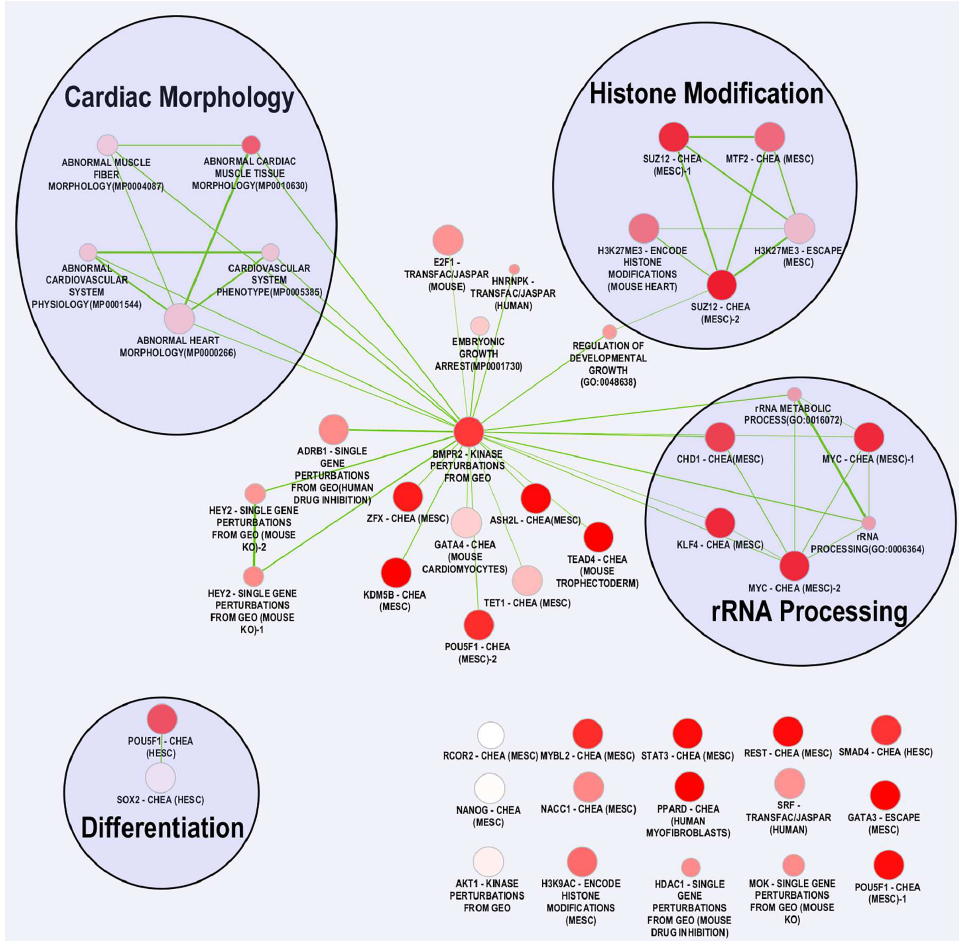
Fig 1. Functional clusters of gene sets enriched with genes in EA CNVs. Network of gene sets that are enrichedfor genes in candidateEA-associated CNVs. Nodes are Enrichr gene sets that showed significant enrichmentof genes in EA-associated CNVs. Clustering was performed with Enrichment Map Cytoscapeapp to identify enrichedgene sets that significantly overlap. Subclusters were manually annotated. Edge weight correspondsto the similarity coefficient between gene sets and node color correspondsto the corrected p-value. Abbreviations: HESC—Human Embryonic Stem Cells, MESC–Mouse Embryonic Stem Cells, CHEA—ChIP EnrichmentAnalysis, rRNA—Ribosomal RNA, GEO—Gene Expression